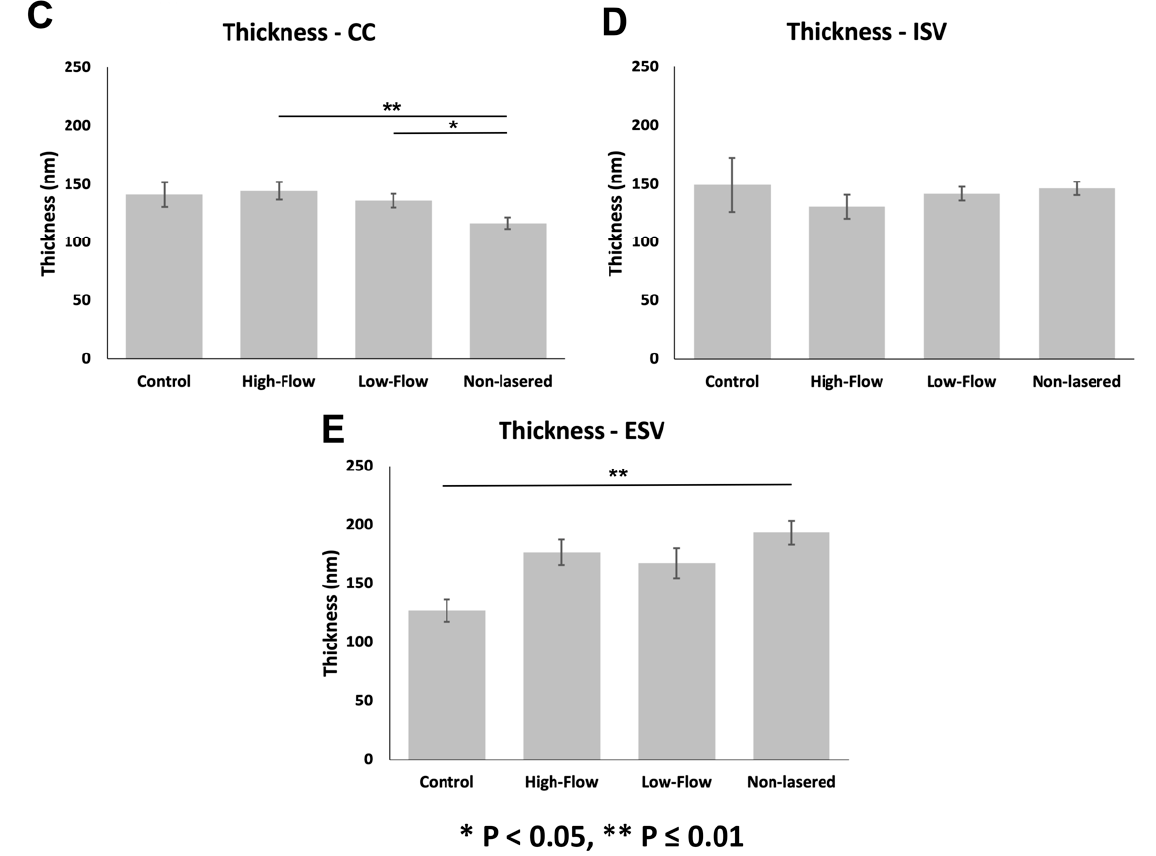
Figure 7. Glycocalyx thickness between different flow regions within various outflow pathway locations ( A ): Thicknesses between flow regions of the TM were not significantly different (ANOVA, F = 1.03, p = 0.38) ( B ): Thicknesses between flow regions of SC were not significantly different (ANOVA, F = 0.53, p = 0.66). ( C ): Glycocalyx thickness in CCs was significantly lower in non-lasered regions than high-flow regions ( p ≤ 0.01) and low-flow regions ( p = 0.04) of controls. ( D ): Glycocalyx thickness across all different flow regions was significantly different in ISVs (ANOVA, F = 2.91, p = 0.04); however, pairwise comparisons revealed no significant difference in coverage. ( E ): Glycoca- lyx thickness in the ESVs was significantly greater in non-lasered regions compared to undetermined- flow regions of control eyes ( p ≤ 0.01). Error bars: SEM. * p < 0.05, ** p ≤